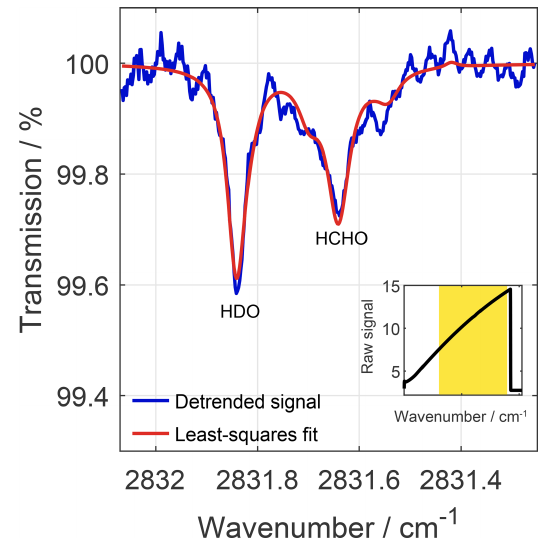
Figure 2. When the H 2 O mixing ratio is above 2000ppmv, the HDO line at 2831.8413cm − 1 rises above the fringing caused by etalons in the detection cell so that the position of the HCHO line at 2831.6413cm − 1 can be reliably located and the spectral line fit. The fit depicted corresponds to a HCHO mixing ratio around 800ppbv. The inset shows the 1Hz raw data from the sensor before baseline subtraction. The yellow shaded region corresponds to the wavelength range being